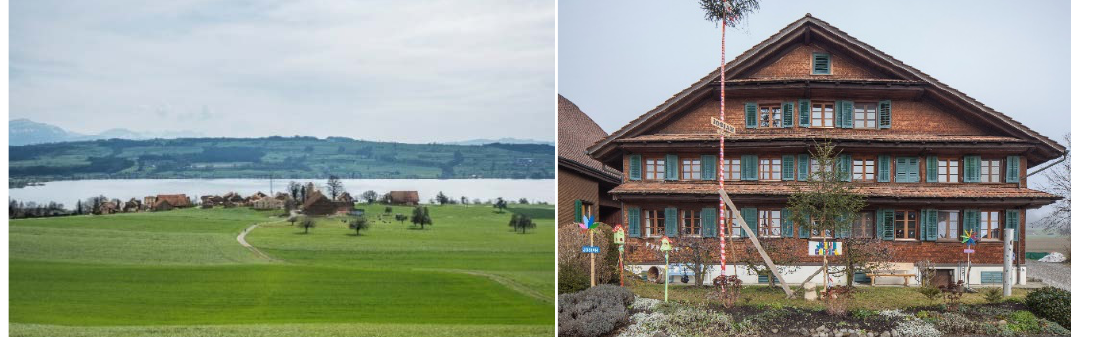
Figure 3: The hamlet of Kirchbühl and surrounding landscape Source: Timo Walker, HSLU, 2017